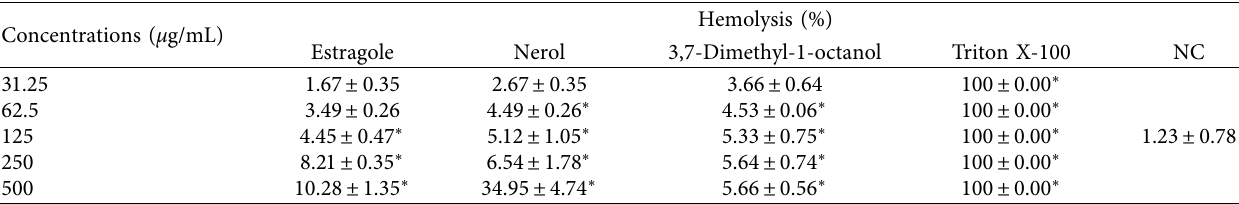
Values are mean ± SD of triplicate value. ∗ p < 0 . 05 vs. NC (ANOVA followed by t -Studentpost-hocNeuman-Keuls test).